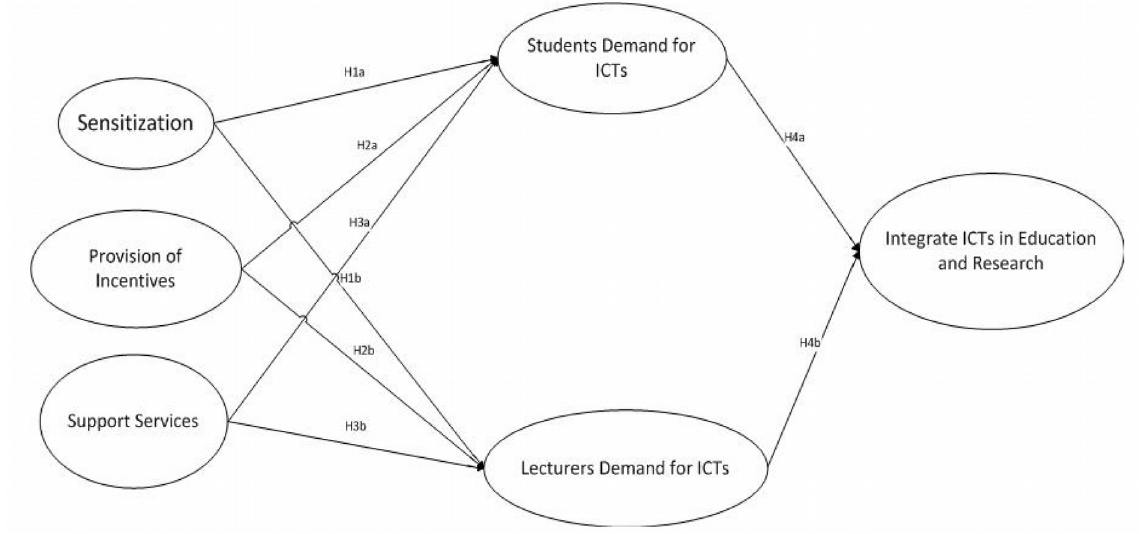
Figure 1. Research